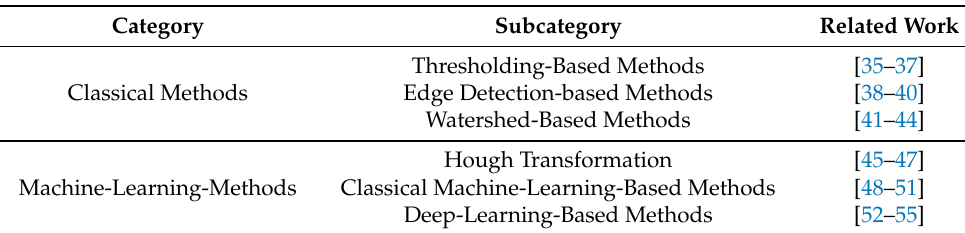
Table 1. Microorganism image counting